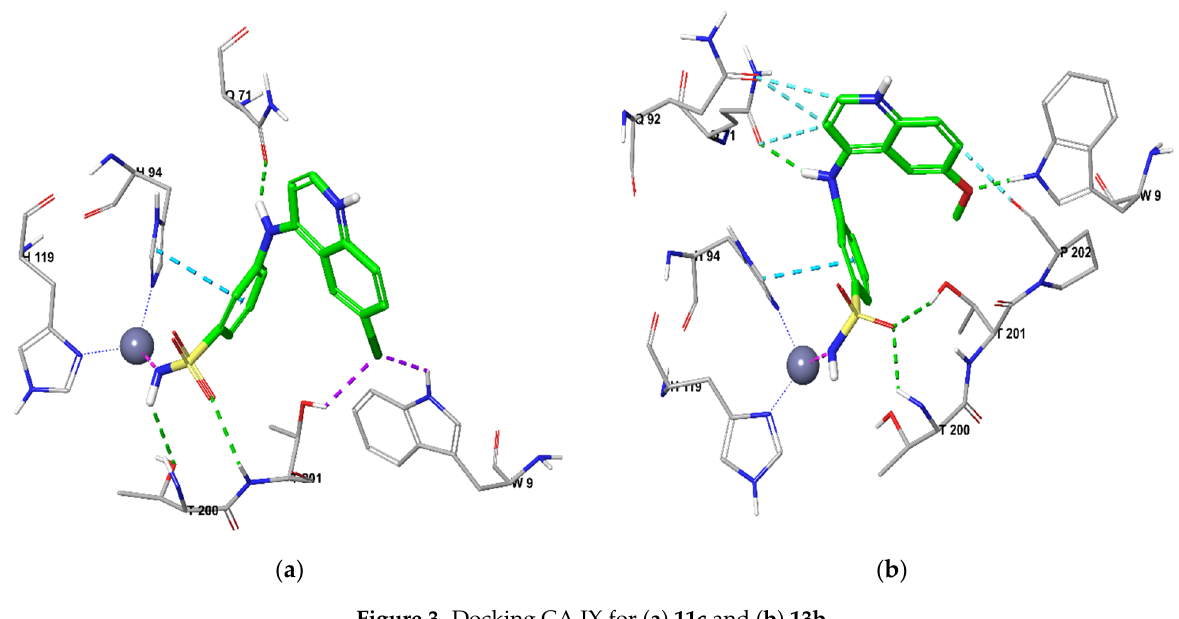
Figure 3. Docking CA IX for ( a ) 11c and ( b ) 13b .